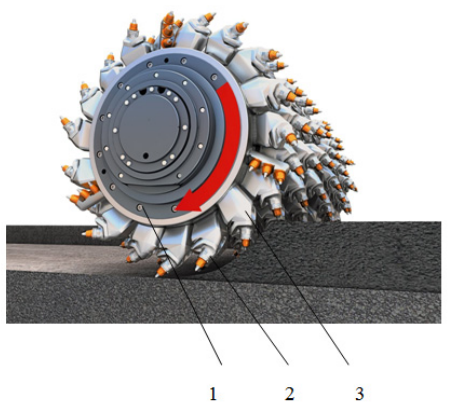
Figure 1. Milling drum: (1) drum; (2) milling tooth; (3) fastening support. The components of a tooth are shown in Figure 2 [5].